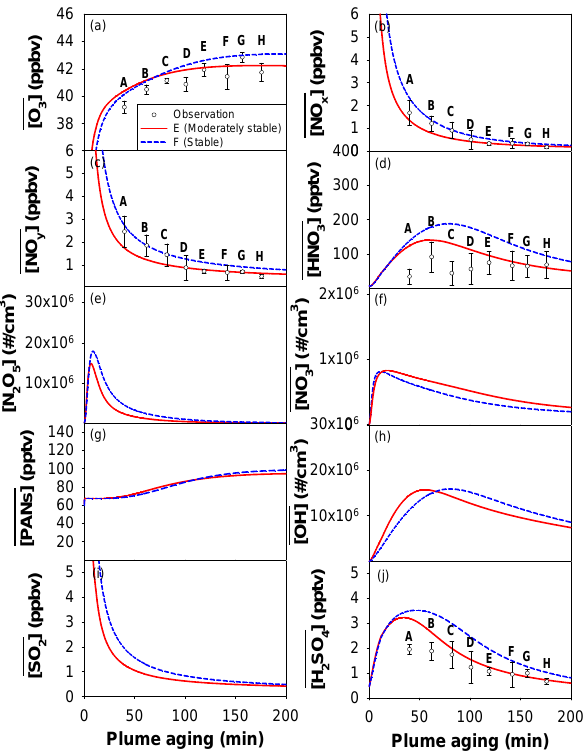
Fig. 13. Changes in ten major ship-plume species concentrations along the ship-plume travel times: (a) ozone; (b) NO x ; (c) NO y ; (d) HNO 3 ; (e) N 2 O 5 ; (f) NO 3 ; (g) PANs; (h) OH; (i) SO 2 ; (j) H 2 SO 4 . The open circles and bars represent the observed average concentrations and concentrations at ± σ , respectively. Here, the model runs were carried out with the stability class of moderately stable (E) and stable